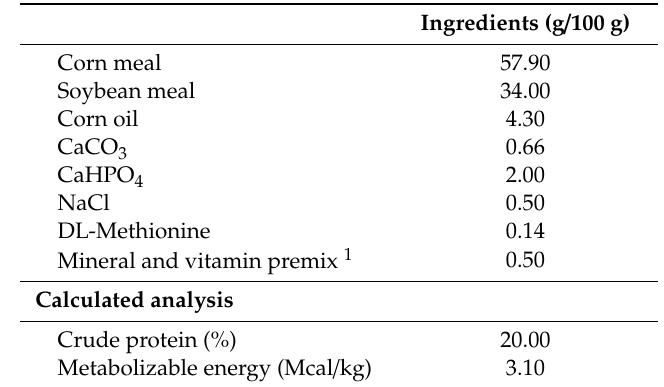
Table 7. Composition and analysis of the basal